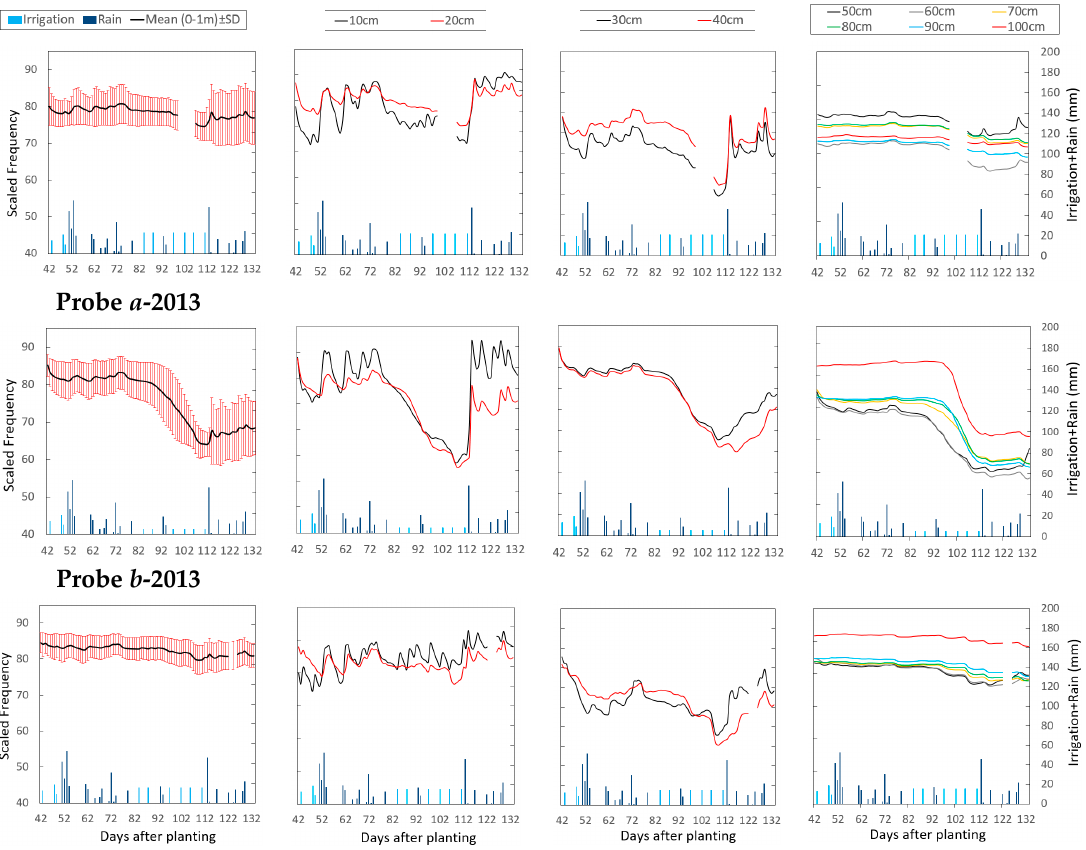
Figure 7. The change in soil moisture, measured as scale frequency (SF, Equation (4)), from 42 days after planting throughout the 2013 growing season in a 73-ha two-pivot supplemental irrigation field in west Tennessee. Light and dark blue bars show irrigation and rainfall, respectively. SF was measured using Agspy soil sensor probes at different locations and 10 depths from 0–1 m. In 2013, soil moisture probes a , b , and c were located underneath the east pivot, representing the pie shape zone with extra irrigation, pie shape zone with lower irrigation, and farmer’s irrigation application, respectively.